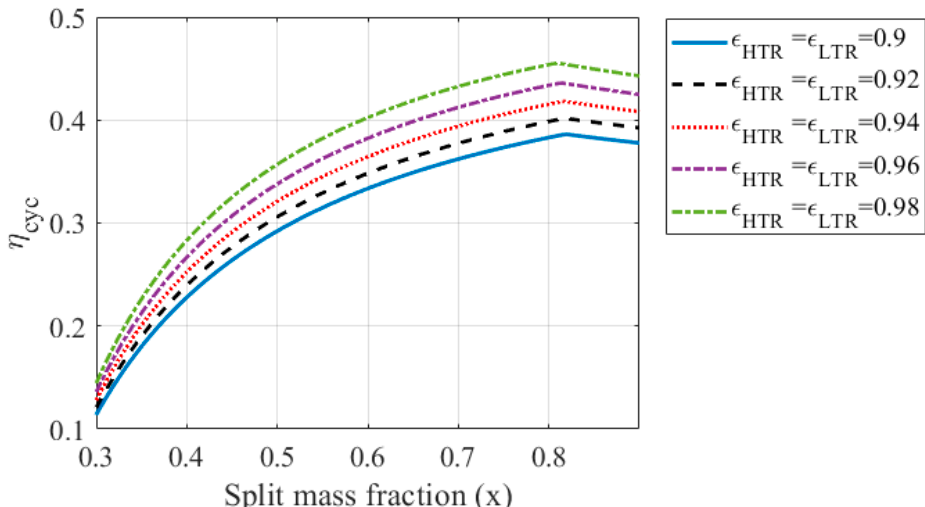
Figure 6. Impact of recuperator’s effectiveness on the cycle’s efficiency.